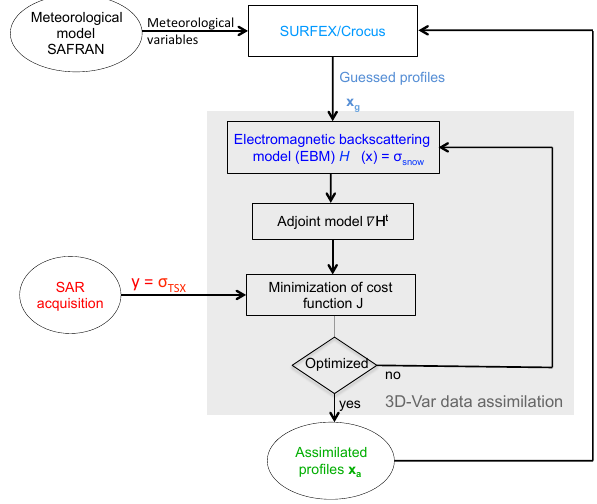
Figure 1. Global schematic of the data analysis used in this study. The inputs of the process are the SAR reflectivities, σ 0 (observa- tion) and the snowpack stratigraphic profile calculated by Crocus (guess). The output is the analyzed snowpack profile x that mini- mizes the cost